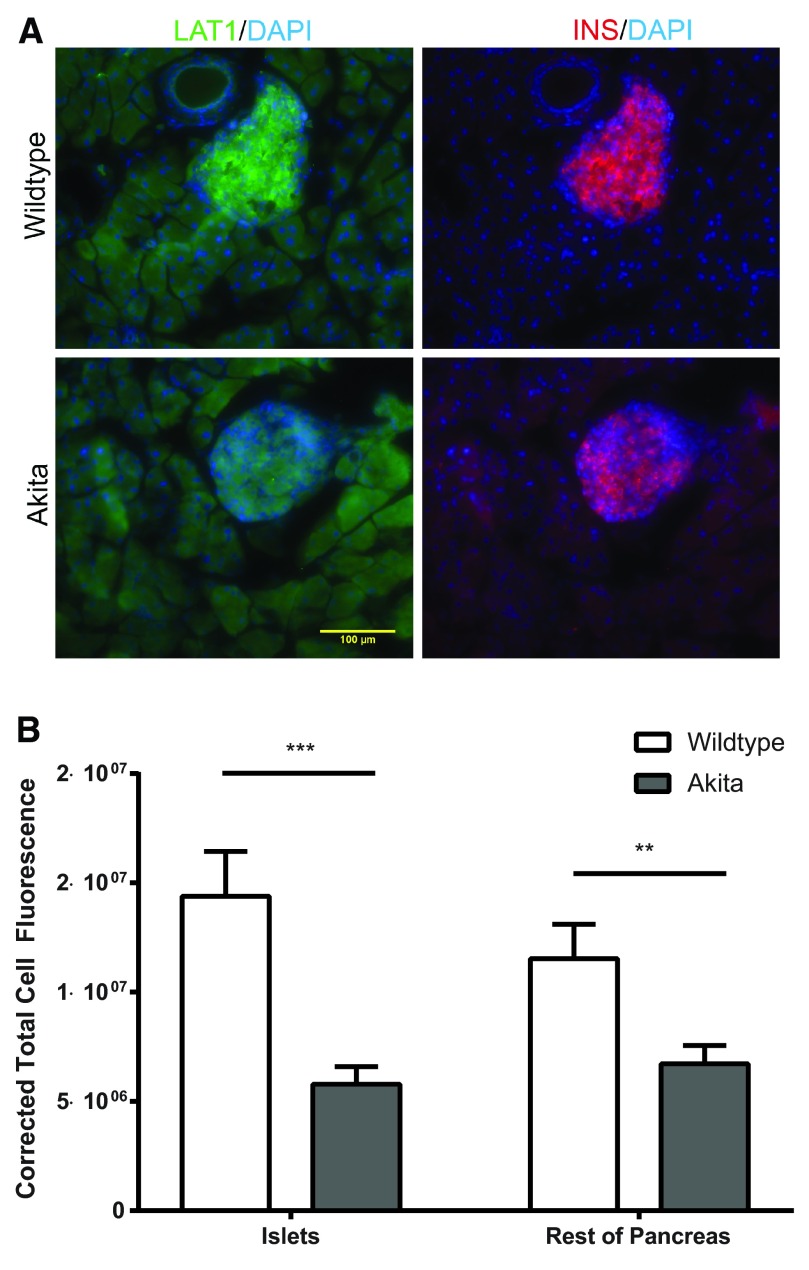
Immunofluorescence microscopy of LAT1 and insulin in the pancreas of wt and Akita mice.
a) Representative fluorescence images of islets and surrounding tissue shows the distribution of LAT1 (green) and insulin (red). Nuclei are highlighted with DAPI staining (blue).
b) Quantification of total corrected cell fluorescence of LAT1 immunoreactivity in islets and the rest of the pancreas. White bars represent values from wt mice, and grey bars represent values from Akita mice. Values are means ± SEM (n=6). * p<0.05 compared to corresponding wt values.